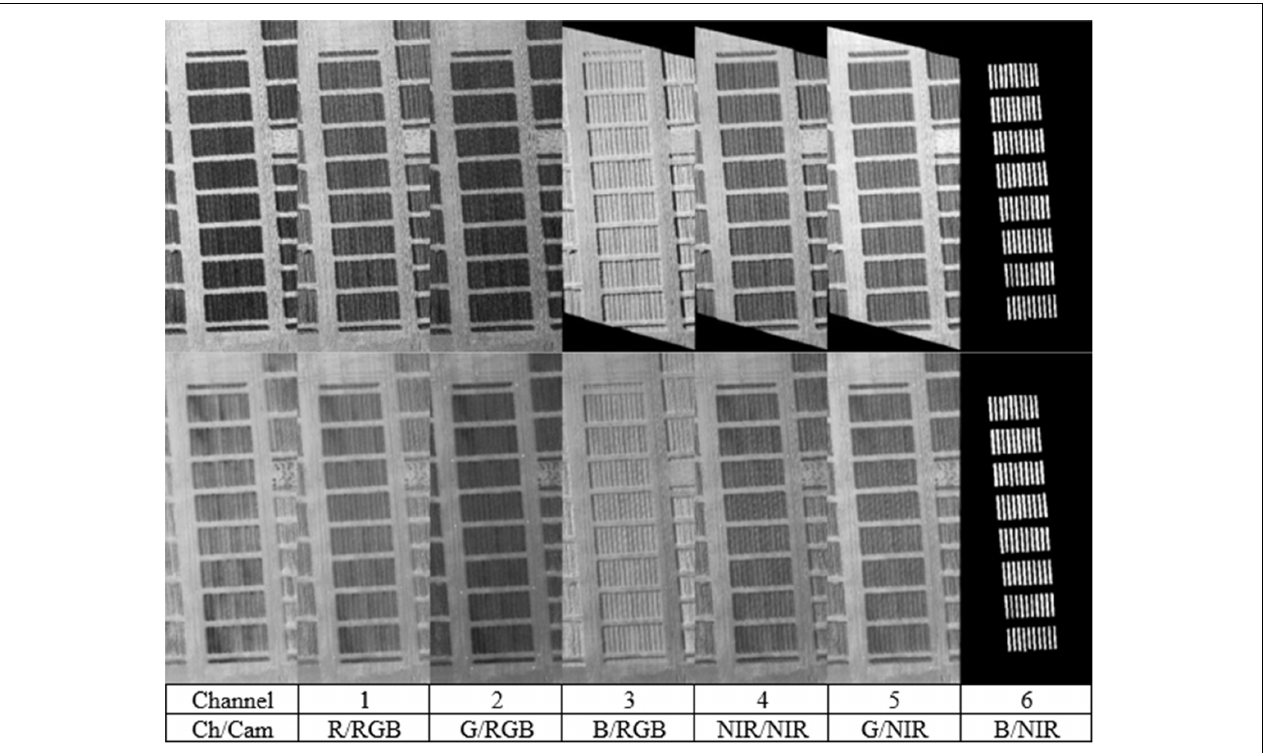
FIGURE 2 | Channel integration, from the two flights (booting and milk stages) over the 1st year. The last image on the right, shows all experiments’ masks combined, similar in both